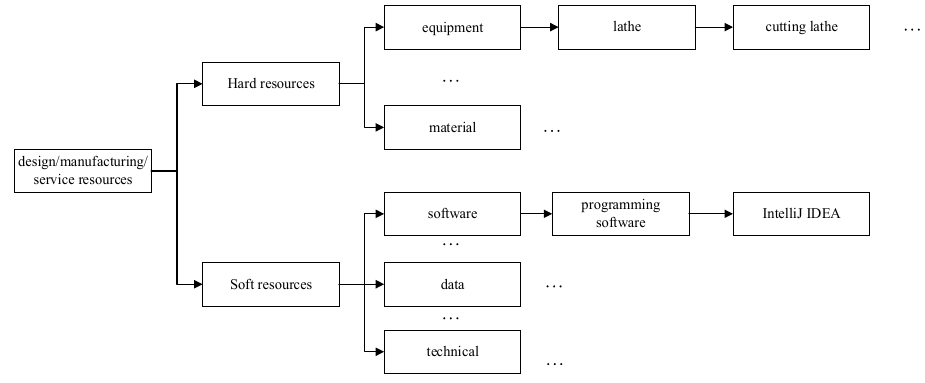
Figure 1. The disordered tree of design/manufacturing/service resource classification.